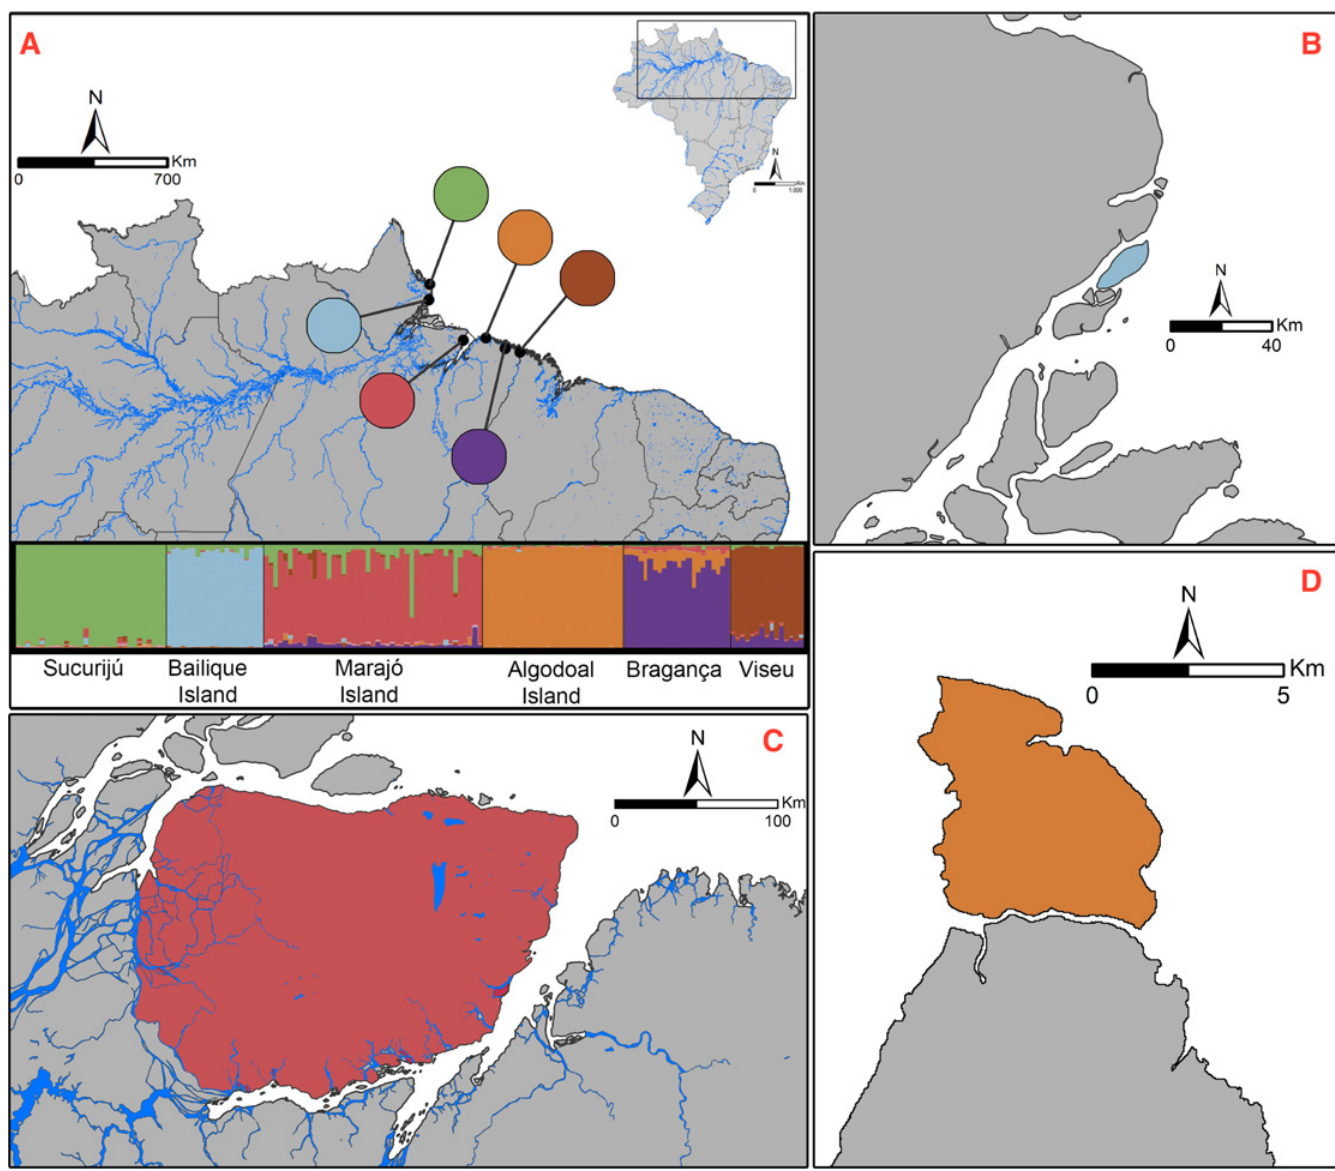
Fig 1. Map of sampled localities of Rhinella marina and Bayesian clustering results of STRUCTURE analysis for microsatellites ( K = 6; see results). (A) Each individual is represented as a vertical line partitioned into K colored segments, whose length is proportional to the individual ’ s estimated membership coefficient. A black line separates individuals of different populations. These are labeled below the figure and are sorted from north to south (from the left to the right of the figure). (B) Bailique Island in blue; (C) Marajó Island in red; and (D) Algodoal Island in orange. Map created using ArcGIS